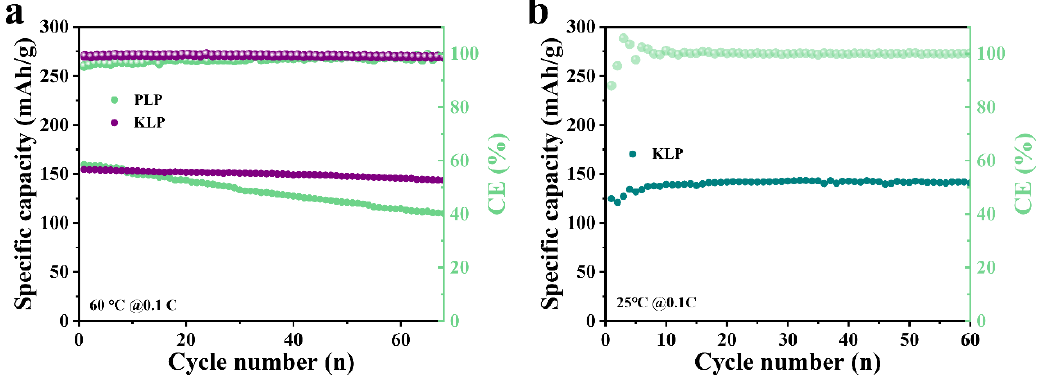
Figure 5. ( a ) Cycling performance of LFP/PLP/Li and LFP/KLP/Li cells at 60 ◦ C; ( b ) Cycling performance of LFP/Li cells at room temperature (25 ◦